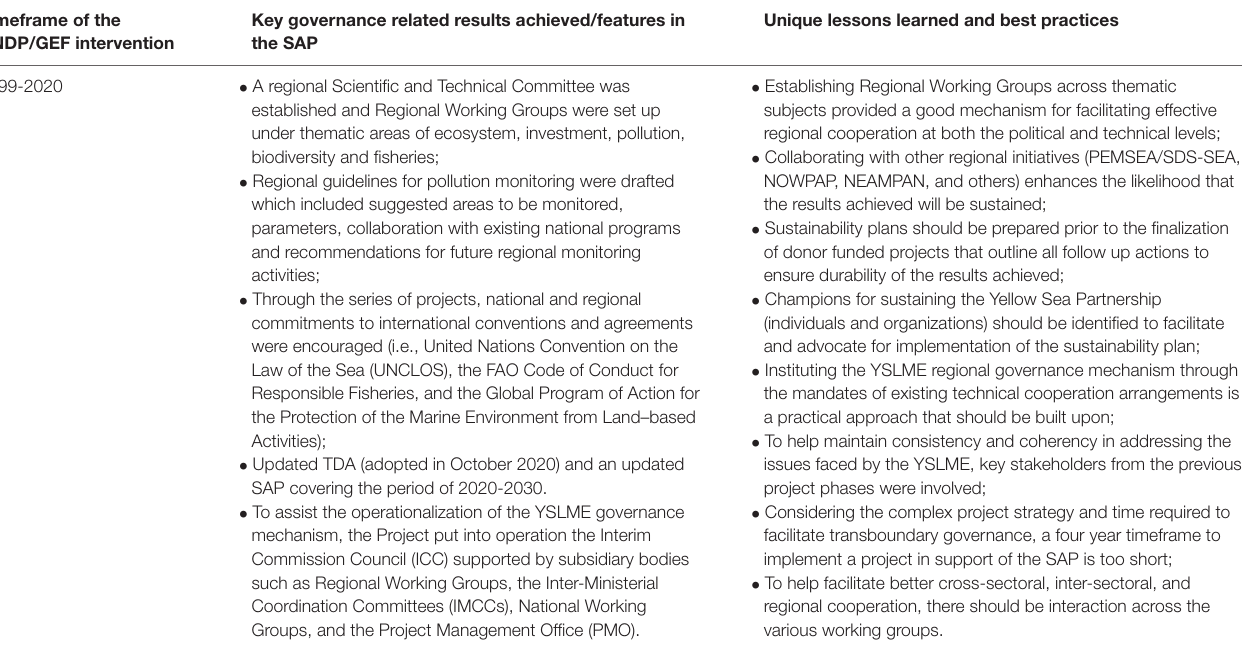
TABLE 6 | Highlighted results of the TDA-SAP process and LME Approach in the Yellow Sea LME, as well as unique lessons learned from the intervention (United Nations Development Programme, 2012a; Lenoci and Shuo, 2020). Timeframe of the Key governance related results achieved/features in UNDP/GEF intervention the